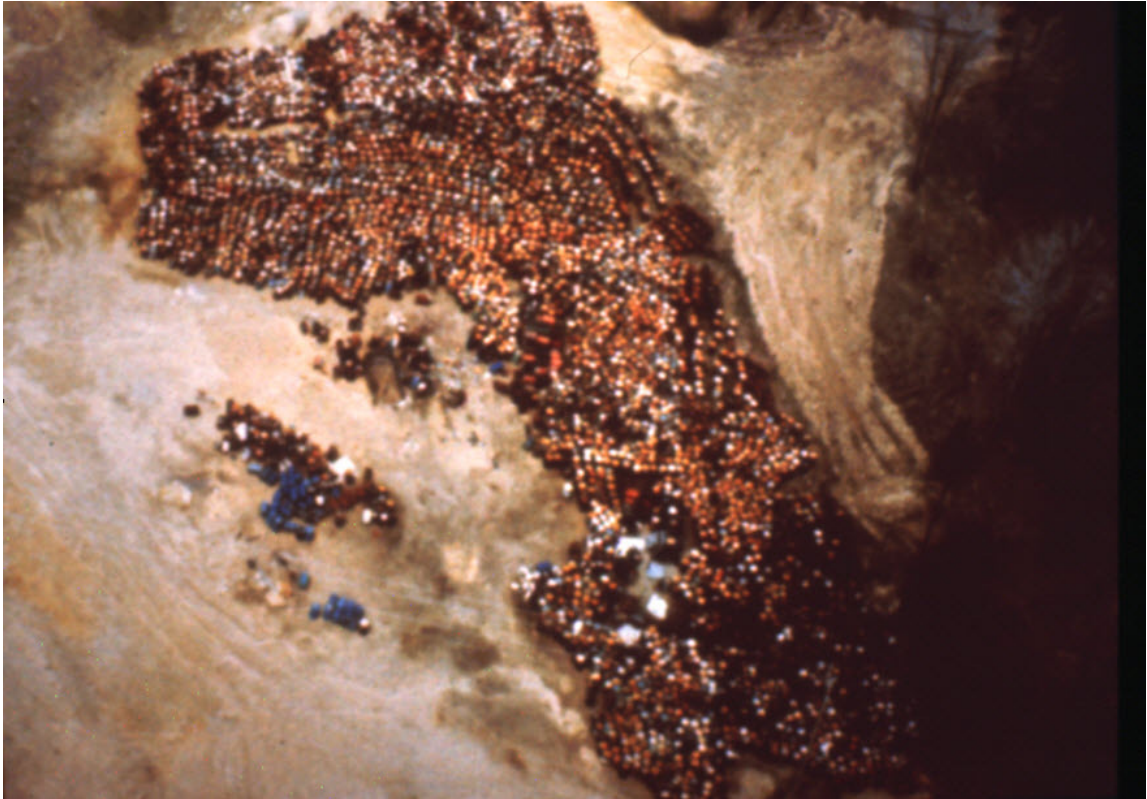
Figure 2. An aerial photograph of a drum disposal site. The photo allows counting and documentation of the number of containers and changes over time. Source: The EPA/Environmental Photographic Interpretation Center